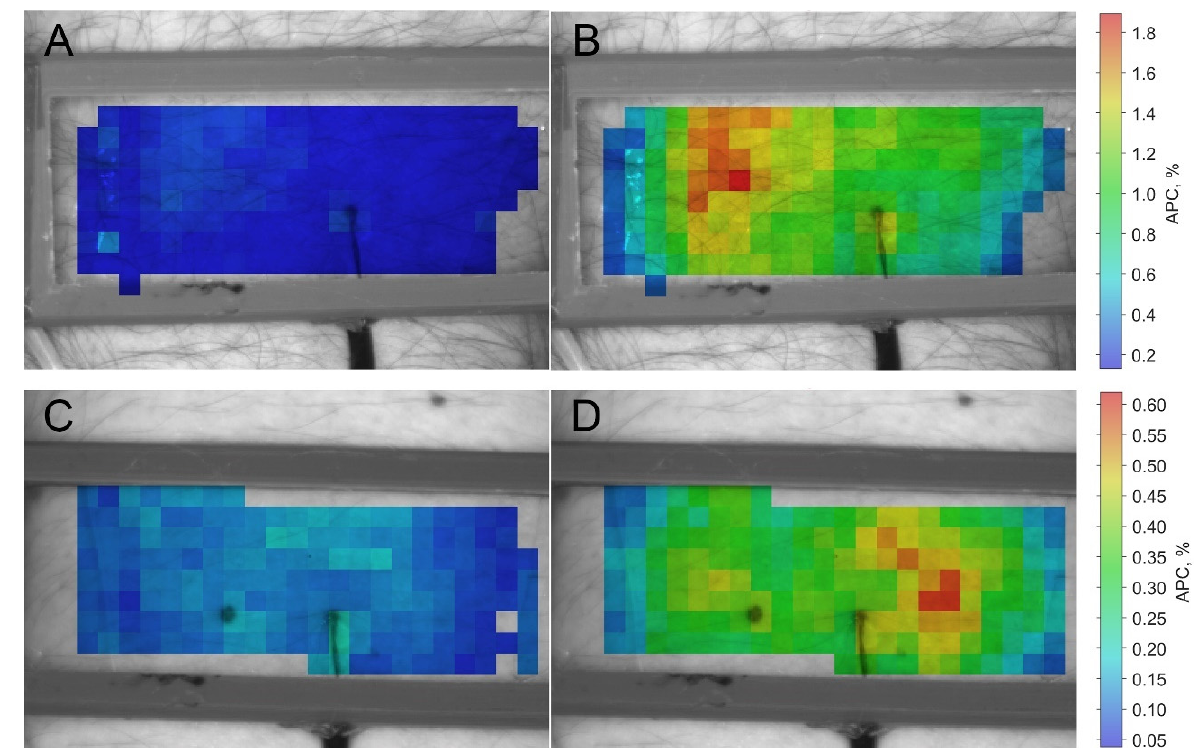
Figure 2. Spatial distribution of the APC parameter (perfusion index) in the region of local heating for two representative subjects. Images ( A , B ) with superimposed maps refer to one subject, while ( C , D ) to another. APC maps in panels ( A , C ) were assessed in the baseline, whereas maps in panels ( B , D ) were evaluated 200 s after the heating element was switched on. The color bars on the right show APC percentagewise, and the scales for basal perfusion and at the time of heating are the same but differ in absolute value for each subject.